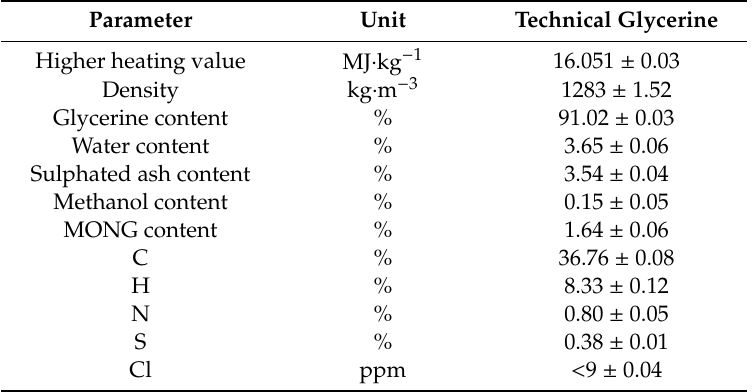
Table 2. Physicochemical properties of by-products from the production of the analysed